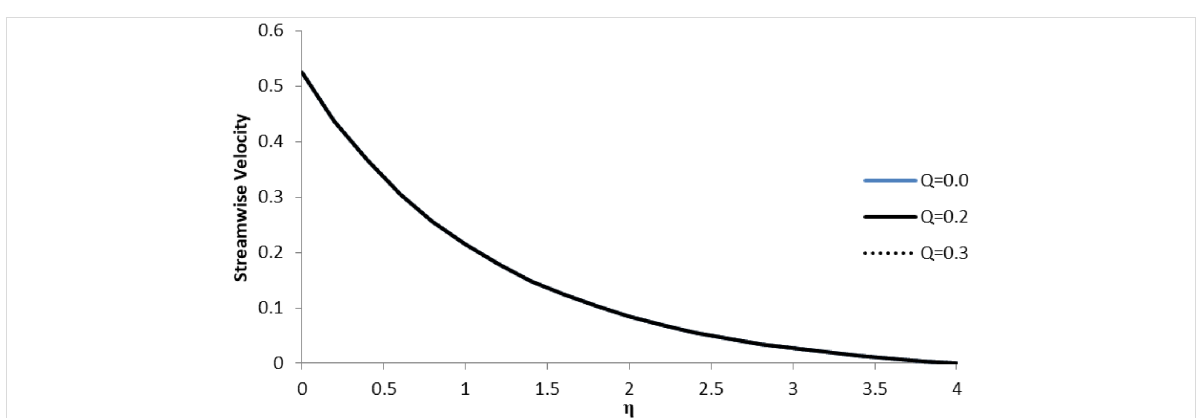
Figure 15: Influence of the heat generation/absorption coefficient Q on the streamwise velocity component f ´( η ) when n = 2.0, Pr = 2.0, Nb = Nt = 0.5, M = 0.0, Le = 5.0, F w = 0.2, and ξ = 1.0.